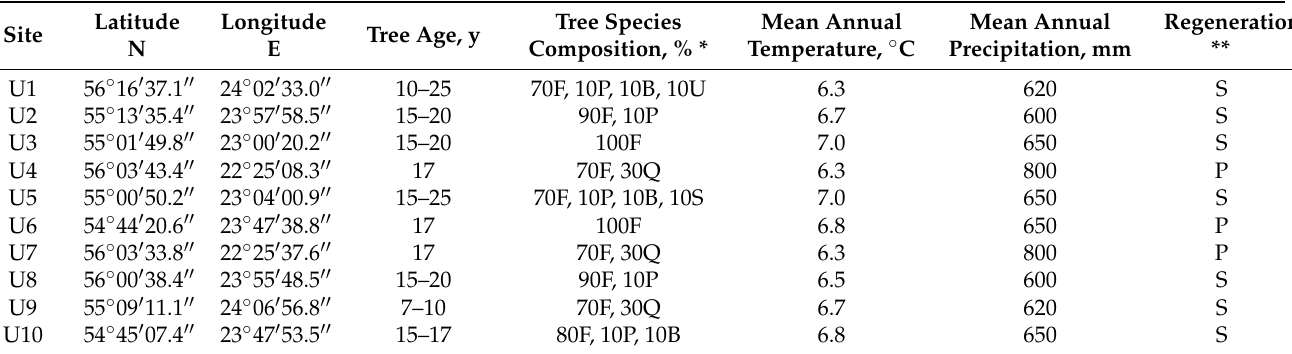
Table 1. Fraxinus excelsior sites in Lithuania used in the present